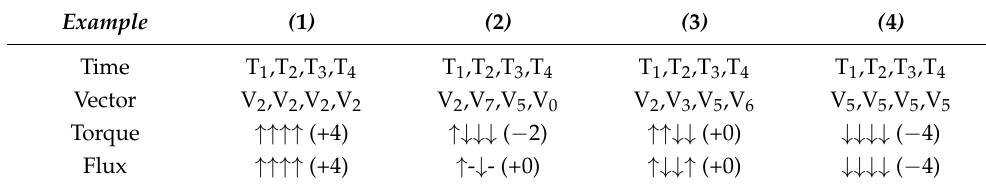
Table 8. Rules for the five-state fuzzy